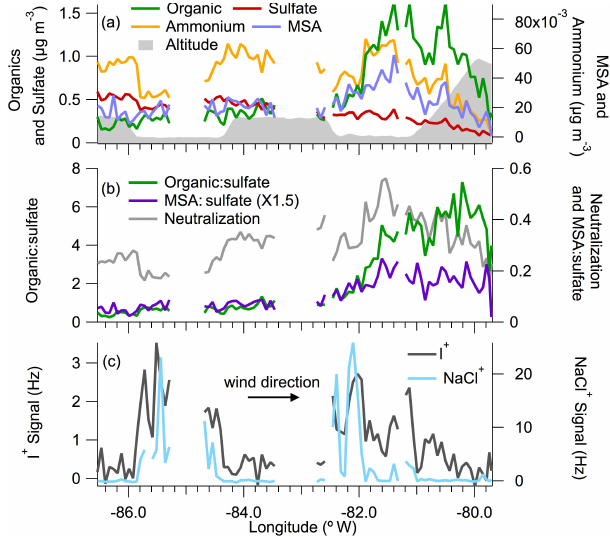
Figure 5. (a) Organic species, sulfate, ammonium, and methane- sulfonic acid (MSA) measured by the HR-ToF-AMS, over the case study area highlighted in Fig. 2a. Altitude is shown in grey on the same scale as Fig. 4. (b) Organic-to-sulfate ratio (green), MSA-to- sulfate ratio (purple), and extent of neutralization (grey). The extent of neutralization is the ratio of measured to predicted ammonium, based on measured sulfate, nitrate, and MSA. (c) I + ( m/z 126.90) and NaCl + signal from the